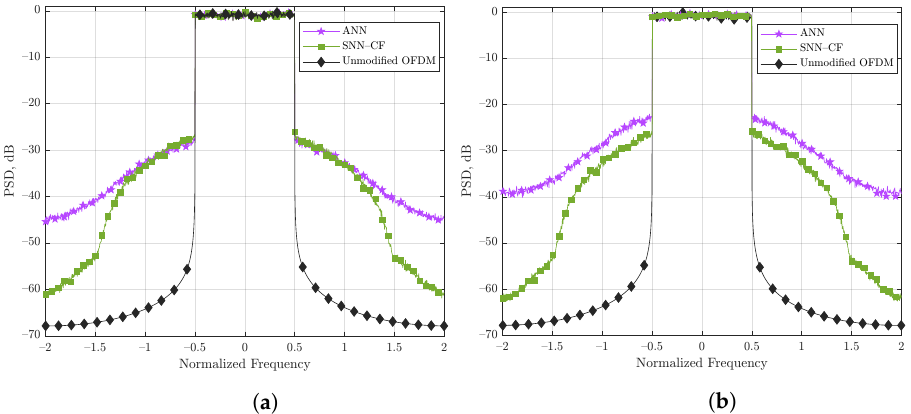
Figure 7. Power leakage performance of the proposed SNN-CF vs. ANN [12] and unmodi- fied OFDM in terms of normalized PSD vs. normalized frequency for ( a ) QPSK-OFDM; and ( b ) 16-QAM-OFDM modulation.